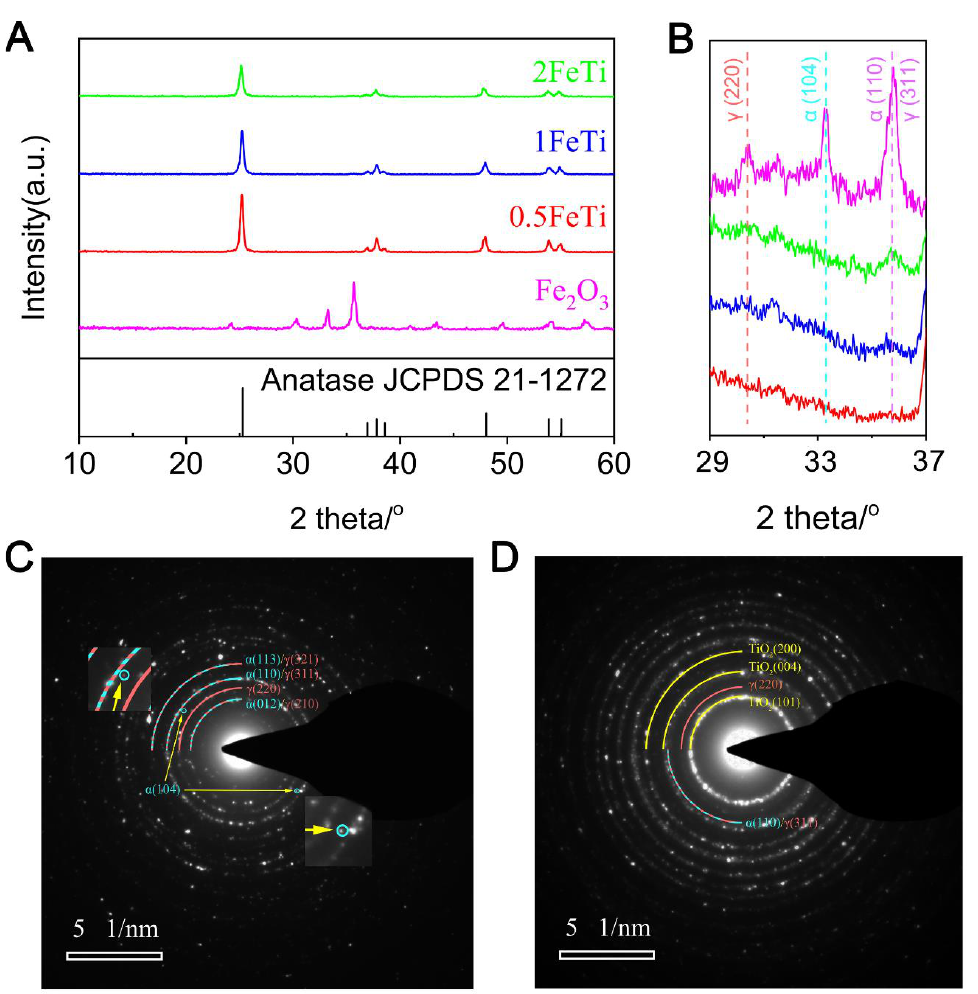
Figure 1. XRD full-range spectra ( A ) and narrow-range spectra ( B ) of Fe 2 O 3 (magenta), 0.5FeTi (red), 1FeTi (blue) and 2FeTi (green); SAED images of Fe 2 O 3 ( C ) and 2FeTi ( D